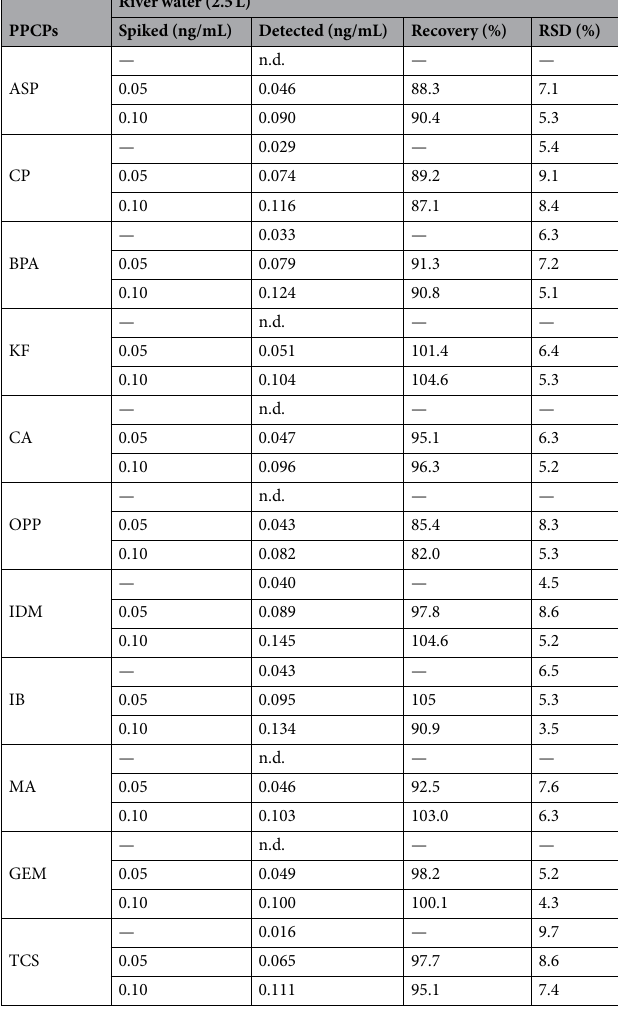
Table 3. Determination of eleven PPCPs and their recoveries from river water samples (n =